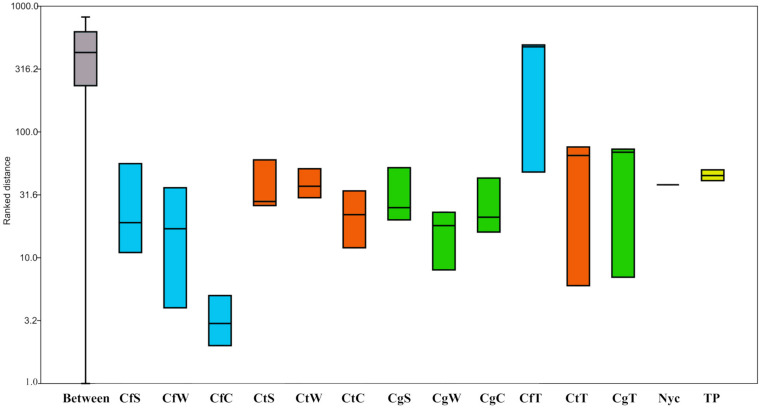
Analysis of similarities (ANOSIM) of all nest materials taken from three captive Coptotermes species. One-way ANOSIM shows the ratio between within-group and between-group dissimilarities. Replicates of each sample, time point, and step (before and after filtration) were grouped together for analysis. PAST v3.18 was used for the calculations based on the Bray-Curtis similarity index. Box-plots were calculated using the interpolated quartile method. No significant differences between two or more groups exist except the termite group (p < 0.01). Cf, C. formosanus (blue); Ct, C. testaceus (orange); Cg, C. gestroi (green); C, carton nest material; W, wood material; S, surface; T, termites; Nyc, before and after 5 μm filtration; TP, four different sampling time points for the C. testaceus carton nest (yellow).